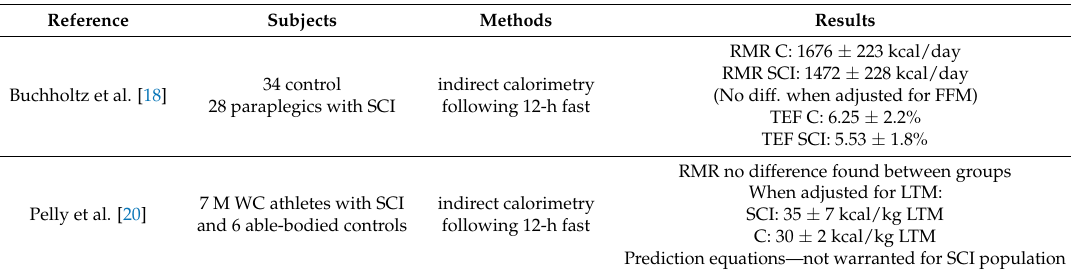
Table 1. Overview of studies that have examined energy expenditure amongst para athletes including athletes with